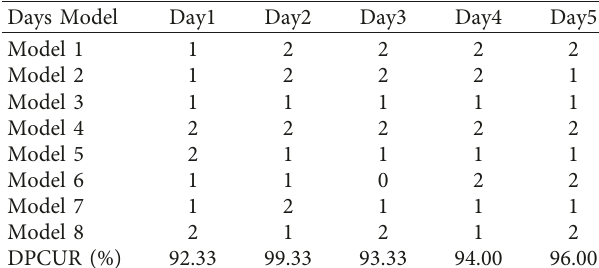
Table 4: Random order sequence of prefabricated walls of pro- duction period 2.